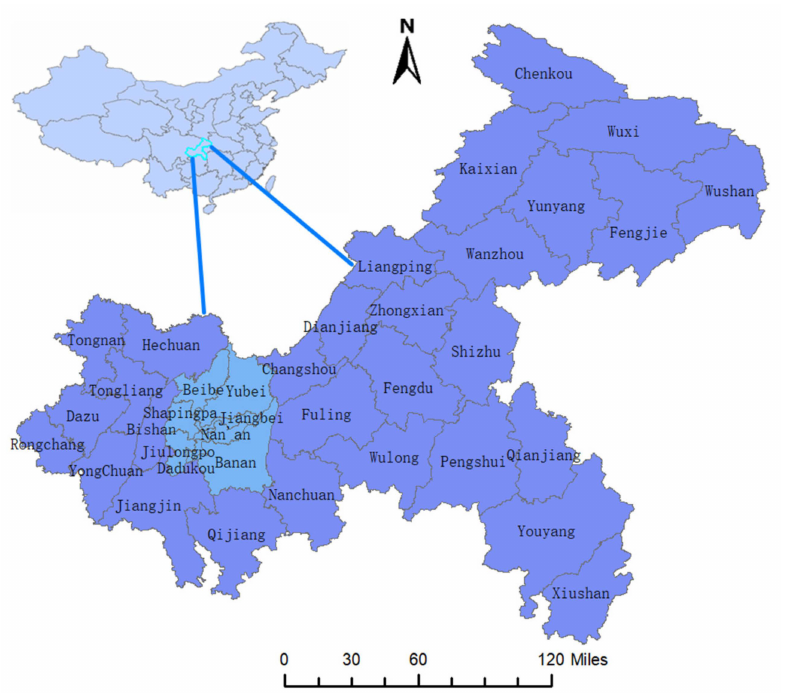
Figure 1. The geographical location and administrative division of Chongqing at the county level in China. The blue part represents the nine main urban